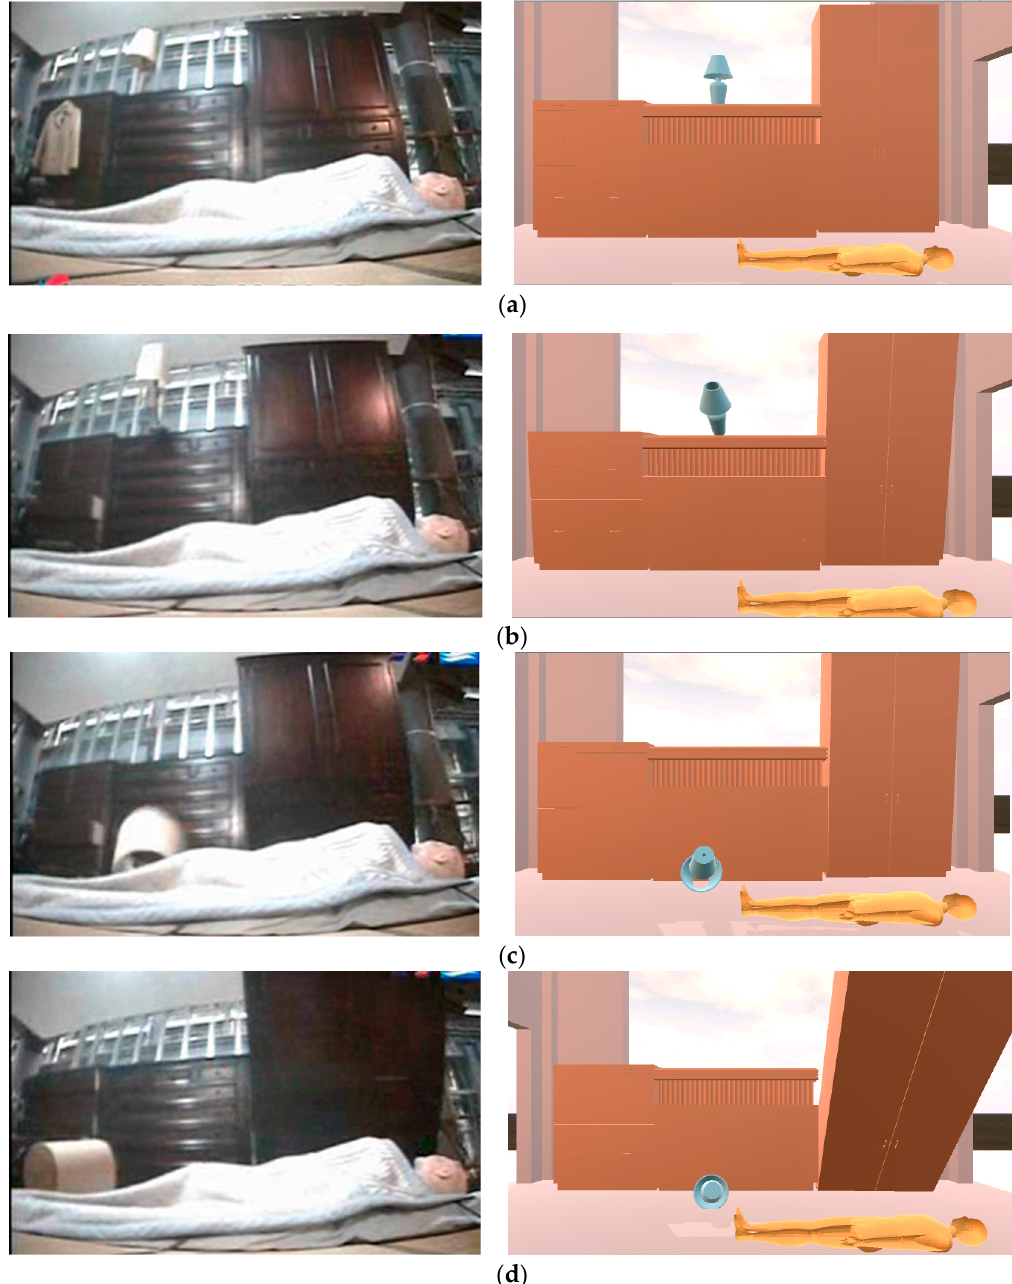
Figure 8. Comparison between the simulation and shaking table test results (Left: results from the video of the shaking table test; Right: simulation results using the proposed physical model), ( a ) original scene; ( b ) the lamp starts to fall; ( c ) the lamp falls down to the floor; ( d ) the wardrobe overturns.